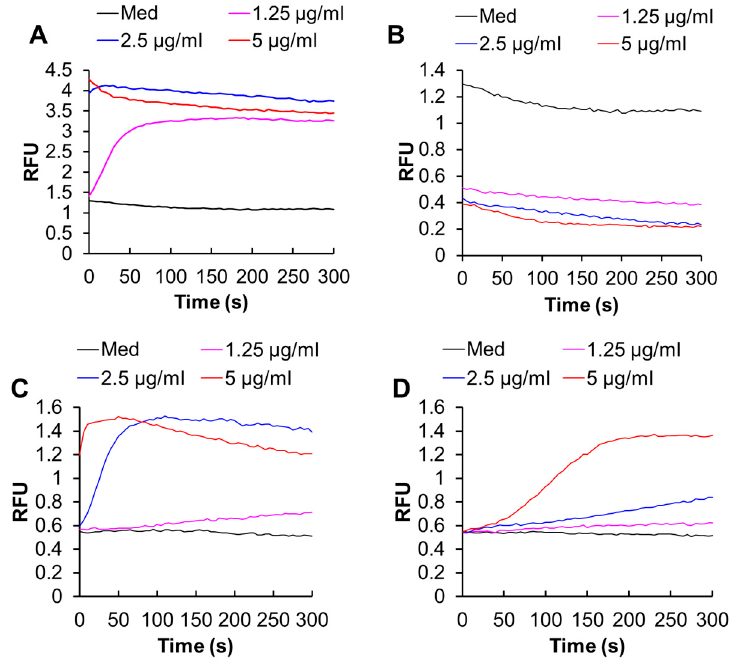
Figure 4. Melittin increases the intracellular Ca 2 + levels in melanoma cells. ( A , B ) A375 cells were loaded with Fluo4-AM , suspended in HBSS containing 1 mM CaCl 2 ( A ) or 1 mM EGTA ( B ), and added with the indicated concentrations of melittin, and measured for fluorescence with excitation and emission at 485 and 538 nm, respectively in a microplate fluorescence reader. The vertical line shows relative fluorescence units (RFU). ( C , D ) The cells were loaded with dihydrorhod-2-AM , suspended in HBSS containing 1 mM CaCl 2 ( C ) or 1 mM EGTA ( D ), and added with the indicated concentrations of melittin, and measured for fluorescence with excitation and emission at 542 and 592 nm, respectively in a microplate fluorescence